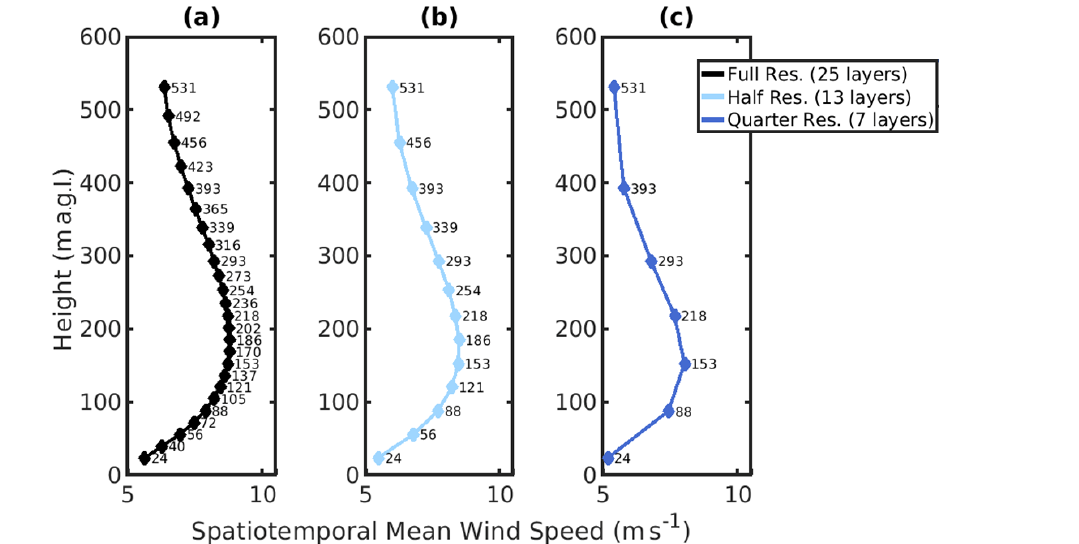
Figure 11. Mean wind speed profiles for output at (a) full resolution (25 layers, no down-sampling), (b) half resolution (13 layers, output down-sampled to every other layer) and (c) quarter resolution (7 layers, output down-sampled to every fourth layer). Note: layers are con- nected linearly for figure visibility, but the LLJ wind speed maxima can only occur at the heights defined at the vertical layers (25, 13 and 7 heights, respectively, for each